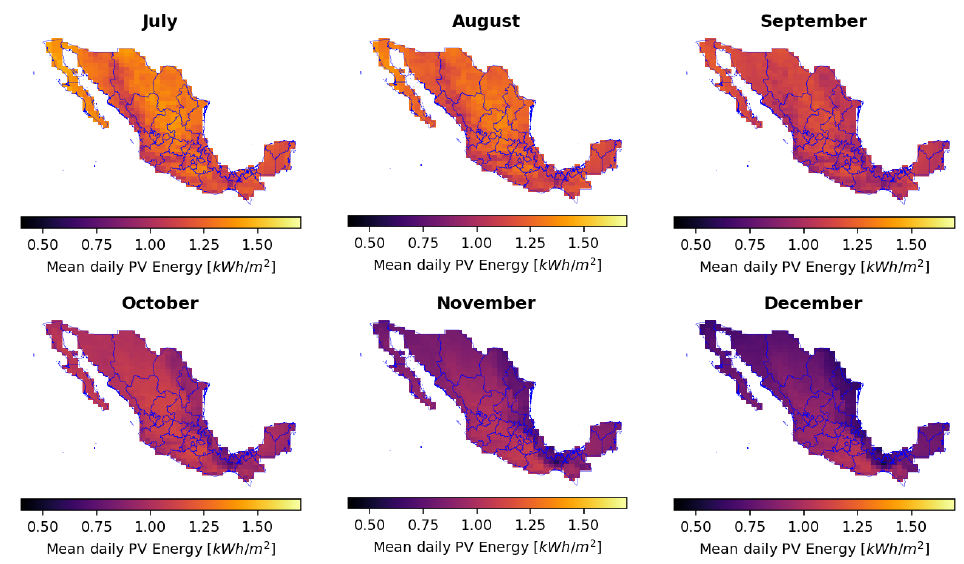
Figure 8. Maps of Mexico for the mean daily PV energy per square meter for each month of the year.